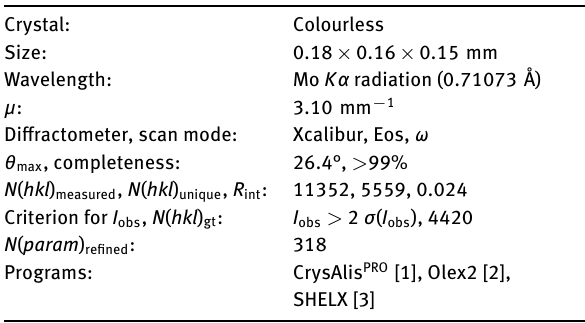
Table 1: Data collection and